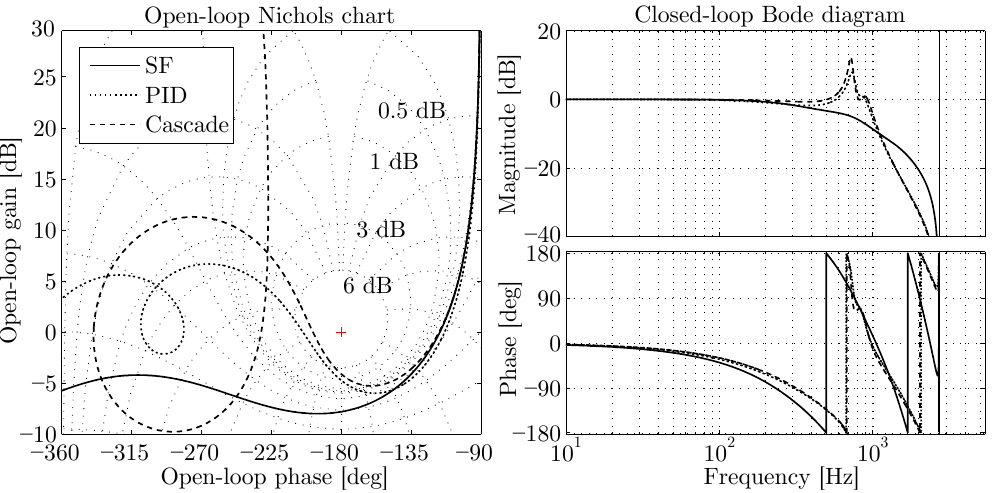
Figure 20. Root locus of ( a ) F (cid:48) zero-pole movement when K p − i increases.